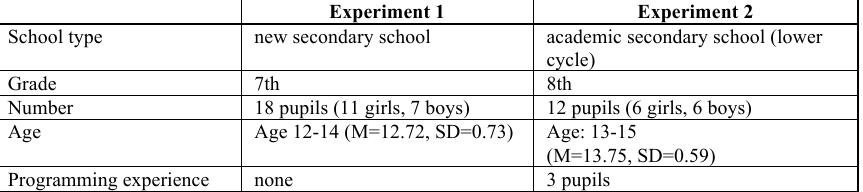
Table 1. Information about the participants in the